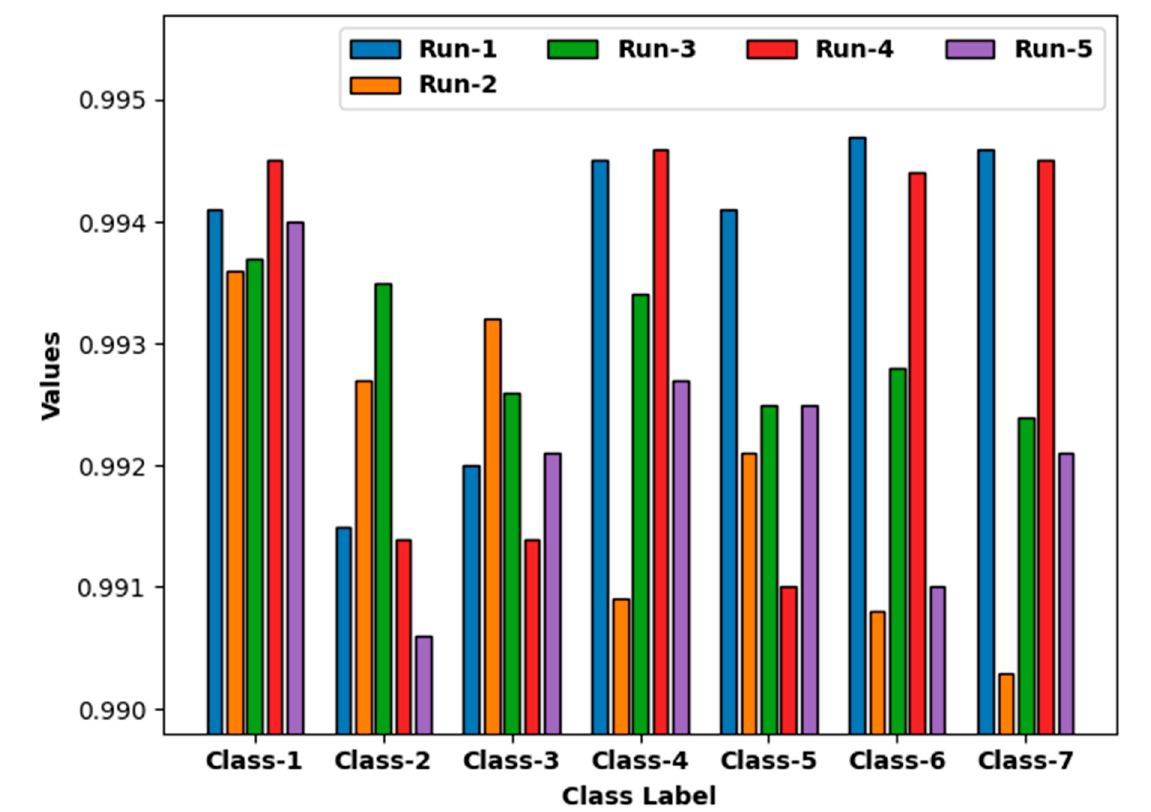
Figure 2. Analytical results of the SPOAI-FD technique under Gearbox dataset. Table 3. Analytical results of Each Fault Class of different methods on gearbox